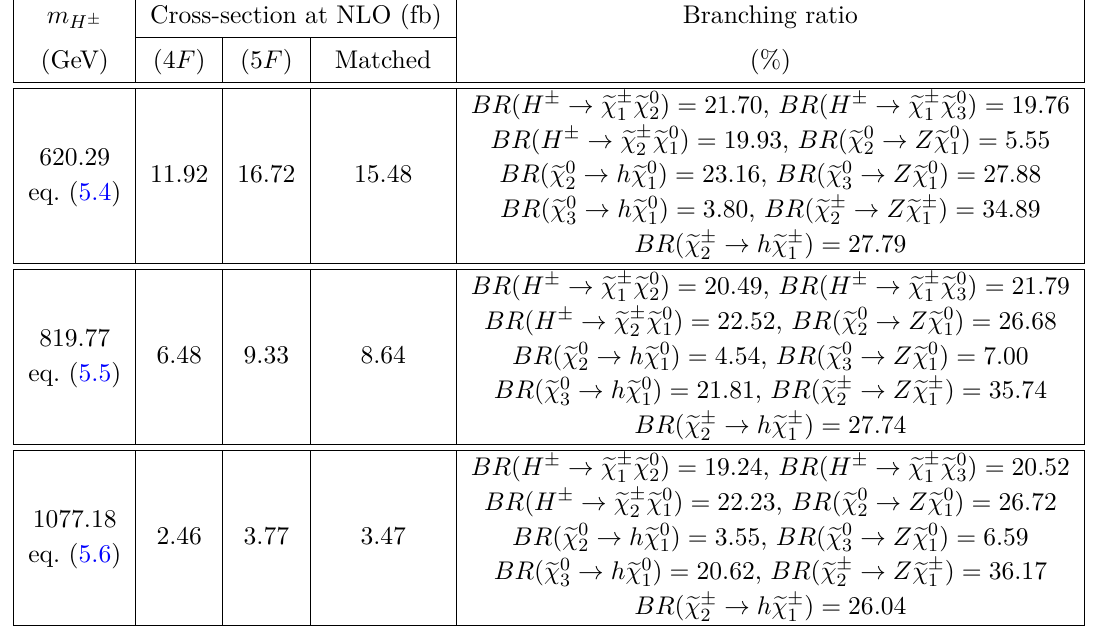
Table 29. The production cross-section and branching ratios for the selected benchmark points in charged Higgs